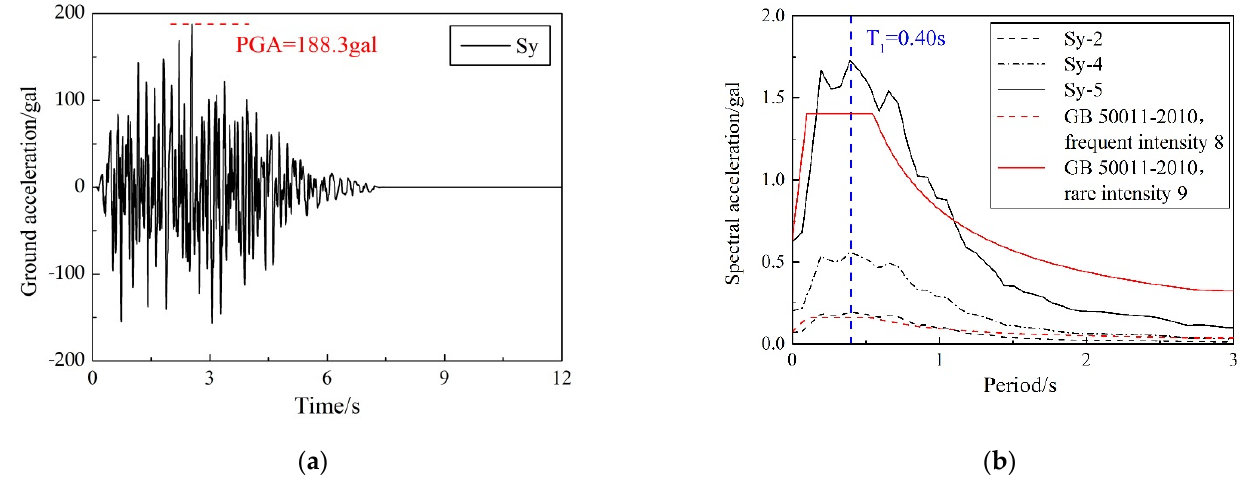
Figure 6. Ground motion Sy: ( a ) acceleration history; ( b ) acceleration-response spectrum. Table 7. Shake-table-loading protocol.